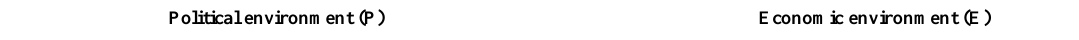
Table 1. Elements shaping individual environments